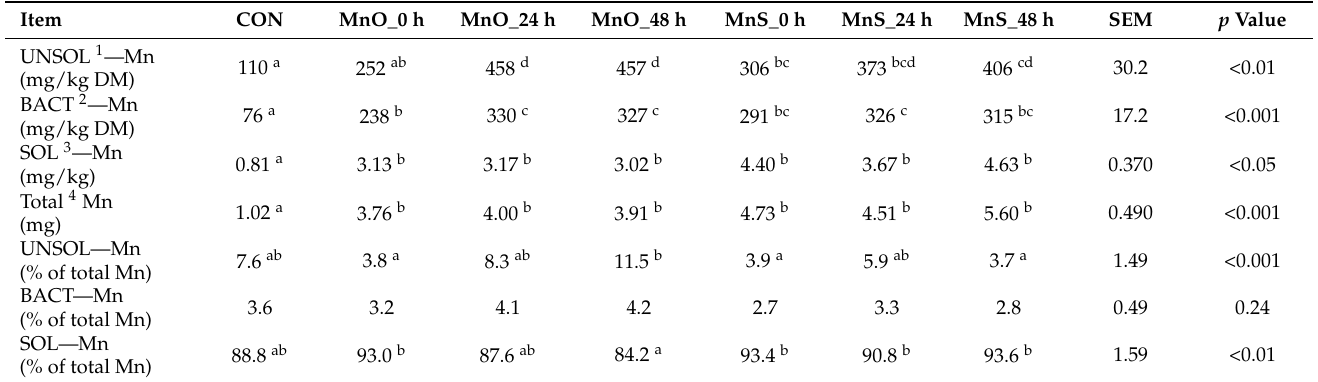
Table 4. Influence of inorganic Mn source and addition time on solubility/bioavailability